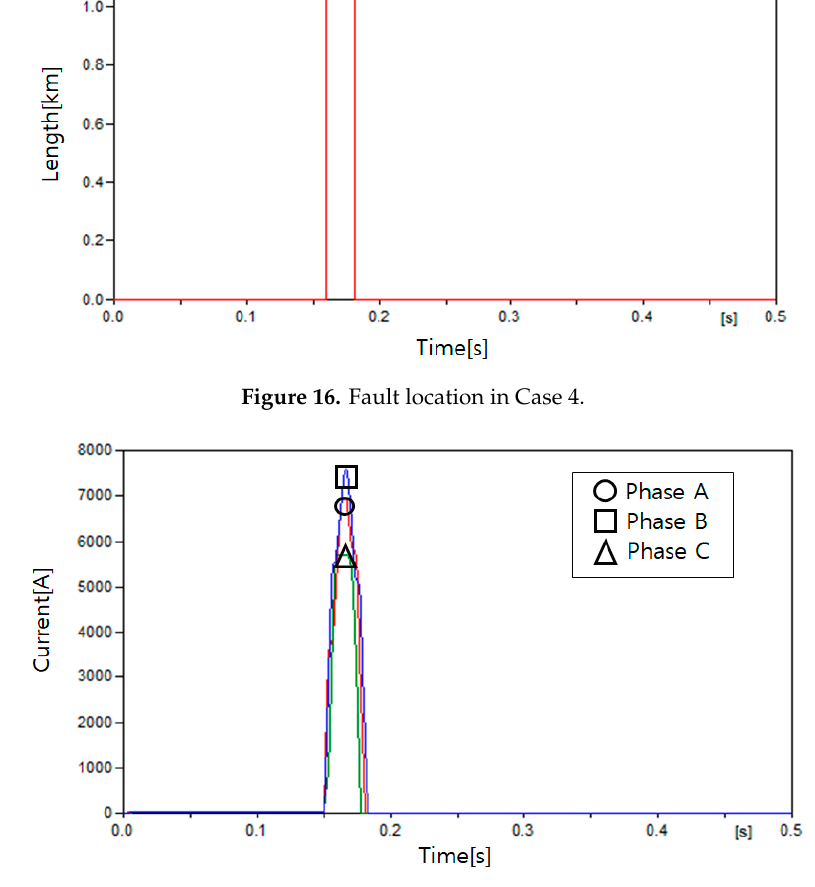
Figure 17. Current measured at I 2 in Case 4.